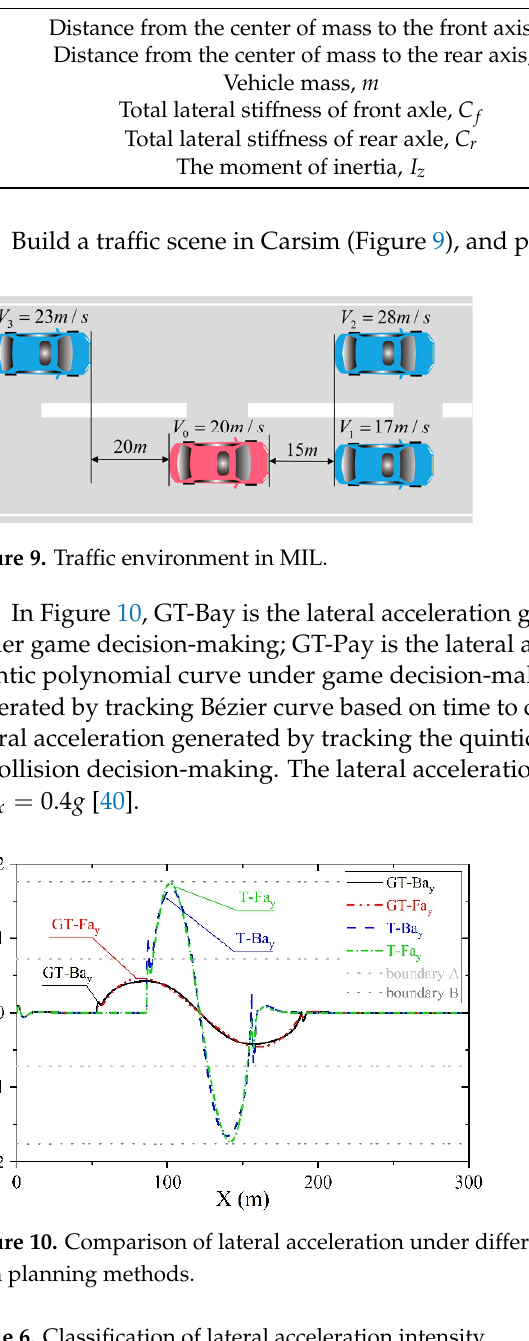
Figure 10. Comparison of lateral acceleration under different combinations of decision-making and path planning methods. Table 6. Classification of lateral acceleration